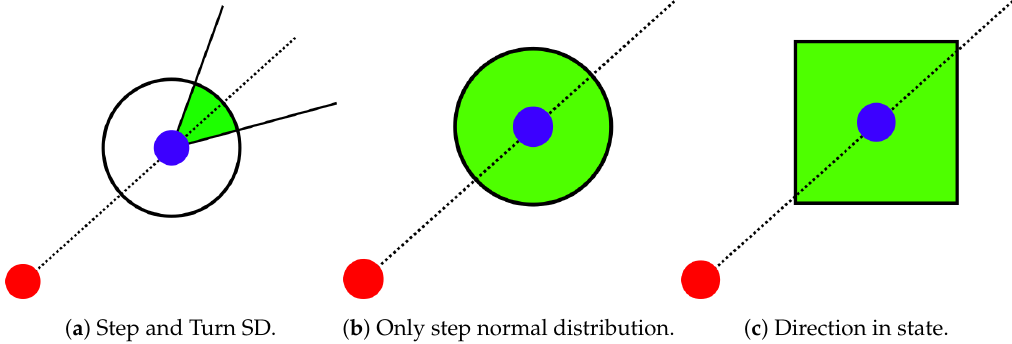
Figure 12. The particle is moved from the red point to the blue point. Afterwards, the particle is transited according to the normal distribution. In panels ( a , b ), the direction is not included in the system